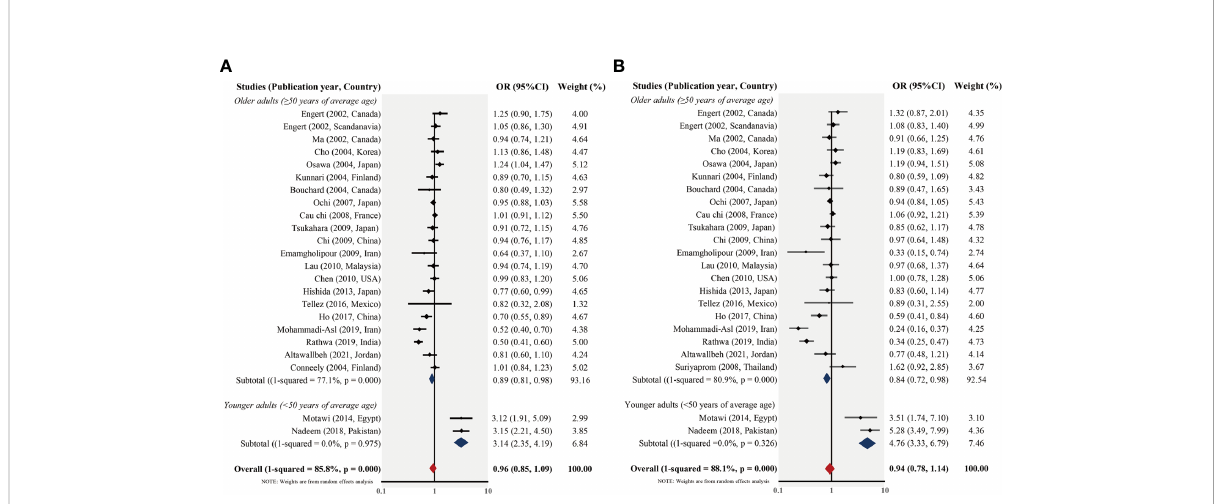
FIGURE 3 Forest plot of the allelic- (G vs. C) (A) and dominant (CG + GG vs. CC) (B) models strati fi ed by the type 2 diabetes mellitus (T2DM) group mean age for the resistin (RETN) -420C/G polymorphism and T2DM